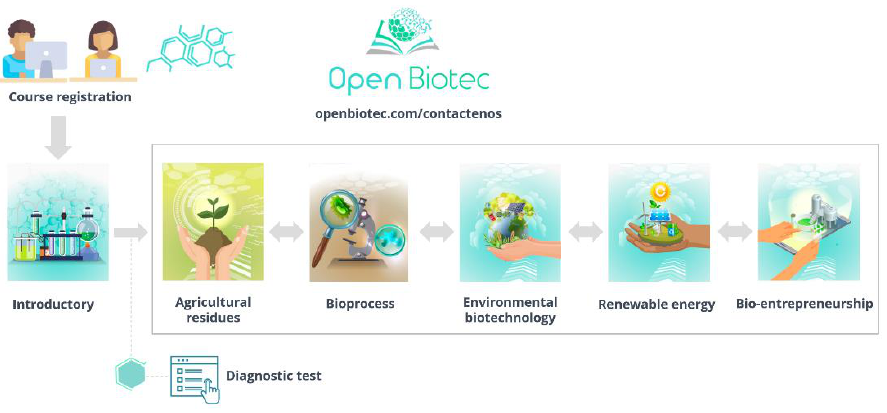
Figure 2. Characteristics of the Open Biotec MOOC courses.